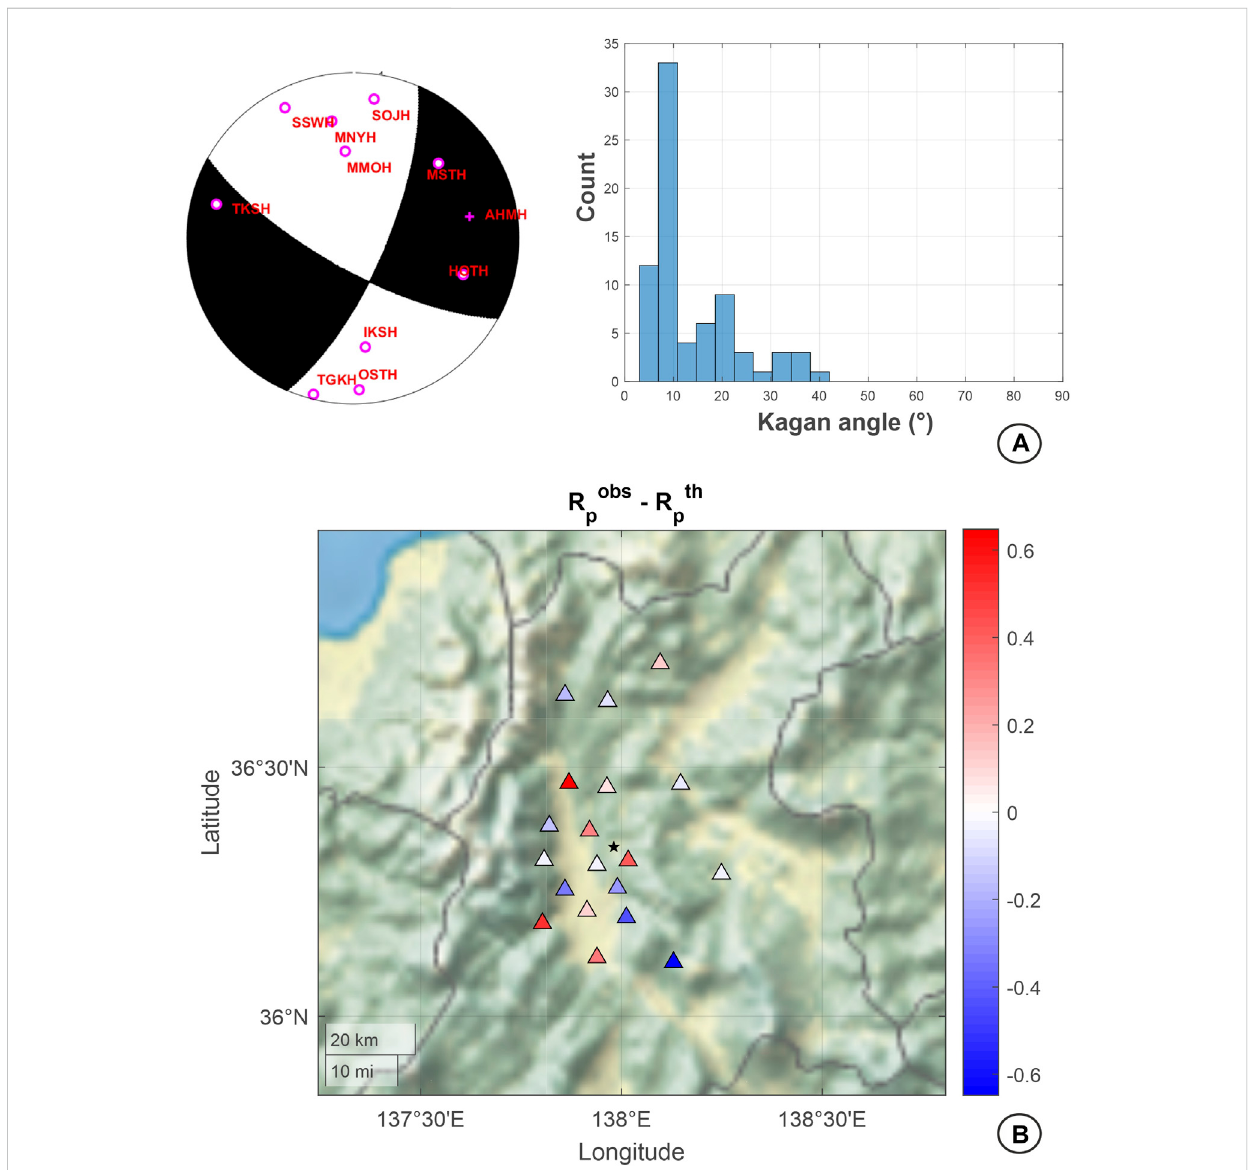
FIGURE 8 Example of fault plane solution computed for the M V 2.5 earthquake on 16/05/2011 at 13:25:04 (JST) in the Nagano region. (A) On the left: focal mechanism solution with the largest probability. The open circles correspond to automatic negative polarities; the crosses are for automatic positive polarities.Stationnamesarelabeledinred.Ontheright:Kaganangledistributionbetweenthebestsolutionandallsolutionsupto95%ofthemaximumof the probability. (B) Map of epicenter location and seismic stations used for focal mechanism calculus. The color-bar refers to the residual between the observed and predicted P-wave amplitude at the available